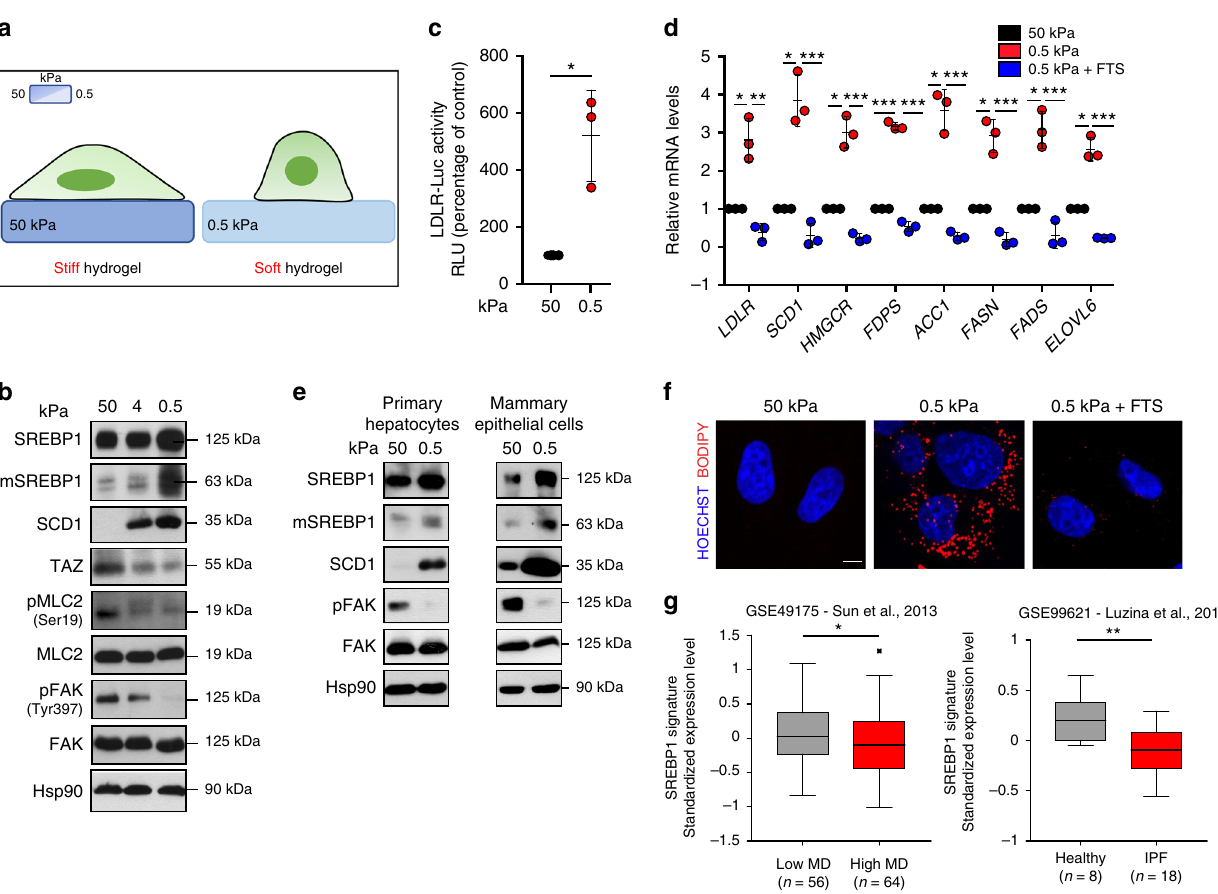
Fig. 3 SREBP1 is under the control of mechanical cues. a Scheme of cell (in green) adhesion to fi bronectin-coated hydrogel matrix (in blue) with 50 and 0.5 kPa elastic modulus. b Western blot analysis of MCF-10A cells cultured on fi bronectin-coated hydrogel matrix of high (50 kPa elastic modulus), intermediate (4 kPa elastic modulus) or low (0.5 kPa elastic modulus) stiffness, for 24 h. c Low density lipoprotein receptor promoter-luciferase (LDLR-Luc) assay in MCF-10A cells cultured on stiff (50 kPa elastic modulus, as control) or soft (0.5 kPa elastic modulus) fi bronectin-coated hydrogel matrix for 24 h. d RT-qPCR quanti fi cation of the expression of the indicated genes in MCF-10A cells cultured on stiff (50 kPa elastic modulus, as control) or soft (0.5 kPa elastic modulus) fi bronectin-coated hydrogel matrix, or soft (0.5 kPa elastic modulus) fi bronectin-coated hydrogel matrix with fatostatin treatment (FTS), for 24 h. e Western blot analysis of primary cultures of hepatocytes and mammary epithelial cells on stiff (50 kPa elastic modulus) or soft (0.5 kPa elastic modulus) fi bronectin-coated hydrogel matrix for 24 h. f BODIPY 493/503 staining of lipid droplets (in red) in Mahlavu cells cultured on stiff (50 kPa elastic modulus, as control, in black) or soft (0.5 kPa elastic modulus, in red) fi bronectin-coated hydrogel matrix, or soft (0.5 kPa elastic modulus) fi bronectin-coated hydrogel matrix with fatostatin treatment (FTS, in blue), for 24 h. Nuclei were stained with HOECHST (in blue). Scale bar, 10 μ m. g Average standardized expression levels of SREBP1 signature in human samples datasets of normal breast tissue with high vs low mammographic density (MD) and Idiopathic Pulmonary Fibrosis (IPF) patients vs healthy controls. Graphs bars represent mean ± s.d. of n = 3 biological replicates. P value: * P < 0.05 by two-tailed Student ’ s t -test ( c , d ) and two-way ANOVA ( g ). For western blots, Hsp90 was used as loading control, mSREBP indicates mature protein. Blots and images are representative of n = 3 biological